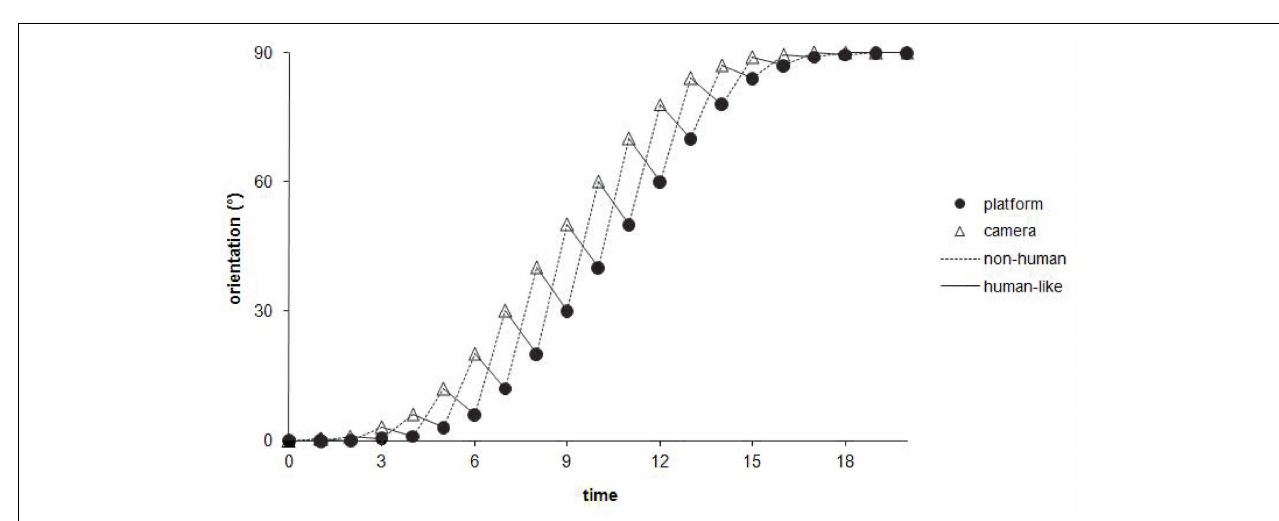
FIGURE 3 | (A) Implementation of visuo-motor anticipation according to a non-human-like model.The camera’s rotation angle is computed by the curve radius ( r ) of the robot’s trajectory, using trigonometric laws. Here, cos a = ( r ( L /2))/ r, where the semi-width of the robot equals L /2 . The radius ( r ) is obtained by dividing the translation velocity by the rotation velocity of the robot. (B) Implementation of visuo-motor anticipation according to a human-like model.The robot’s navigation angle ( S ) is defined as the